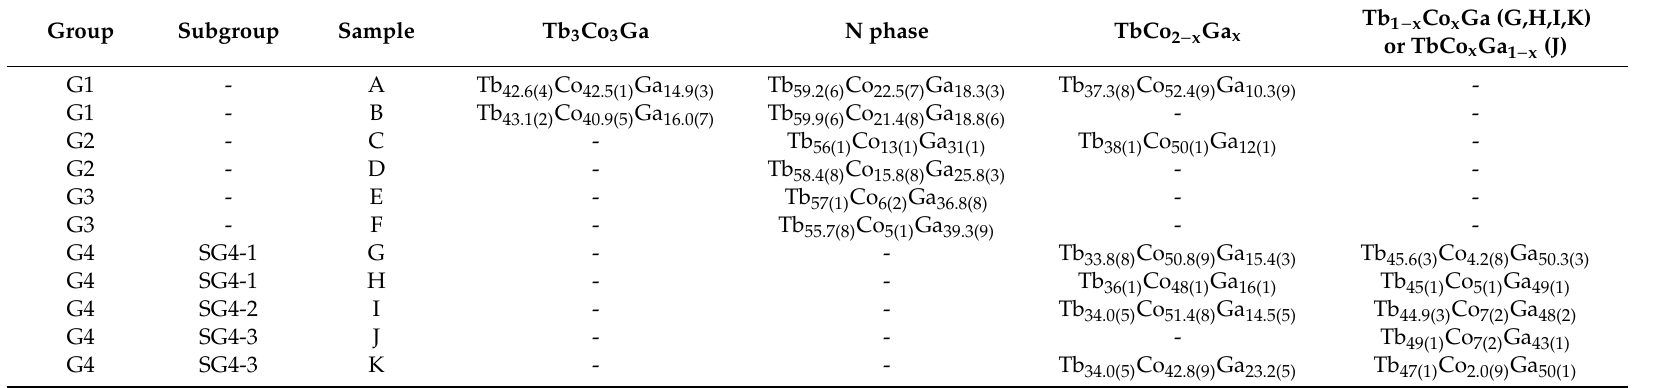
Table 2. Atomic compositions of impurity phases determined by EDX measurement for prepared